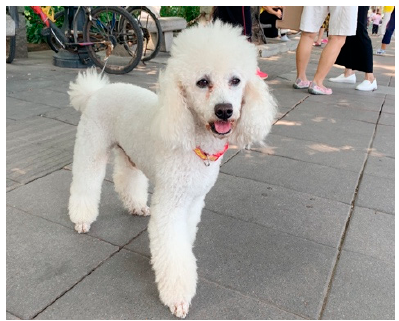
Figure 2. Didi accompanies interviewee No. 8 to a dance.